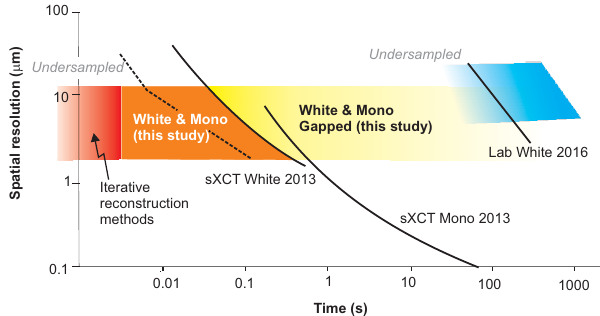
Figure 10. A schematic showing the current state-of-the-art imag- ing capabilities for synchrotron and laboratory XCT scanning (mod- ified after Bultreys et al., 2016; Maire and Withers, 2014).